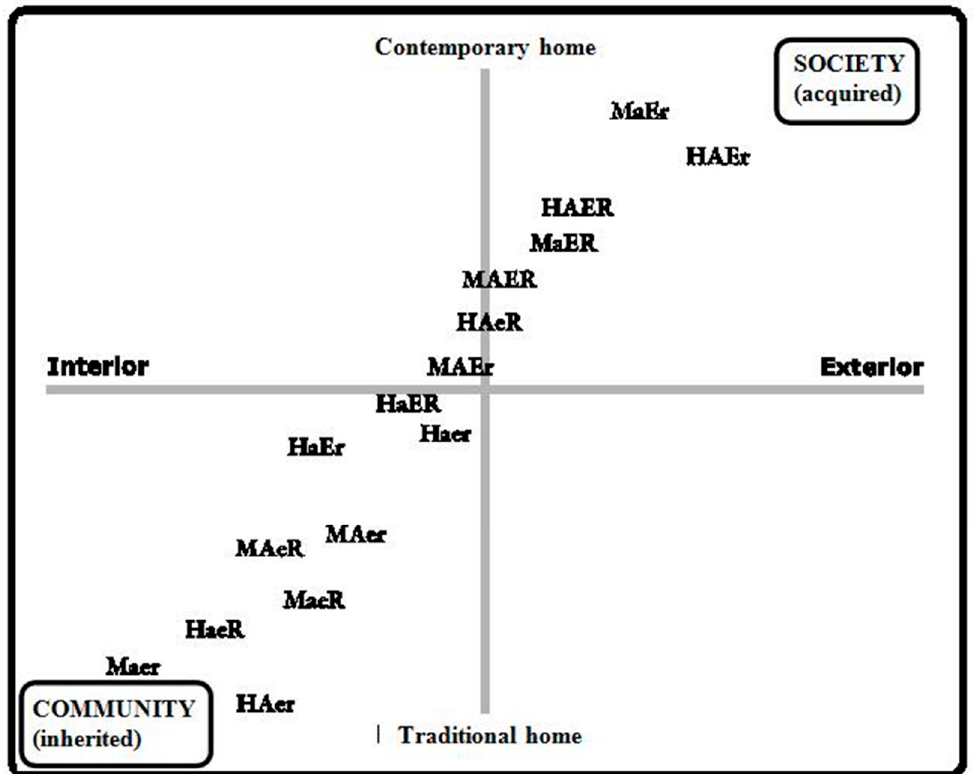
Figure 1. Map positions of respondents. MAER: woman, with autonomy, higher education, with social and family network. MAEr: woman, with autonomy, higher education, with poor social and family network. MaeR: woman, with autonomy, basic studies, with social and family network. MaER: woman, without autonomy, higher education, with social and family network. MaEr: woman, without autonomy, higher education, with poor social and family network. MaeR: woman, without autonomy, basic studies with social and family network. Maer: woman, with autonomy, basic studies, with limited social and family network. HAER: man, with autonomy, higher education, with social and family network. HAEr: man, with autonomy, higher education, with poor social and family network. HaeR: man, with autonomy, basic studies, with social and family network. HaER: man, without autonomy, higher education, with social and family network. HaEr: man, without autonomy, higher education, with poor social and family network. HaeR: man, without autonomy, basic studies with social and family network. Haer: man, with autonomy, basic studies, with limited social and family network.